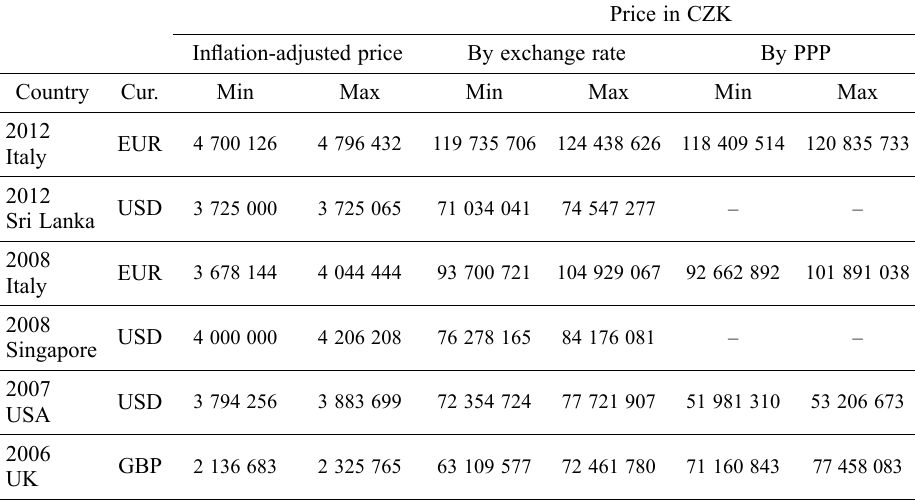
Table 6. Conversion-estimated prices to CZK according to exchange rates and PPPs